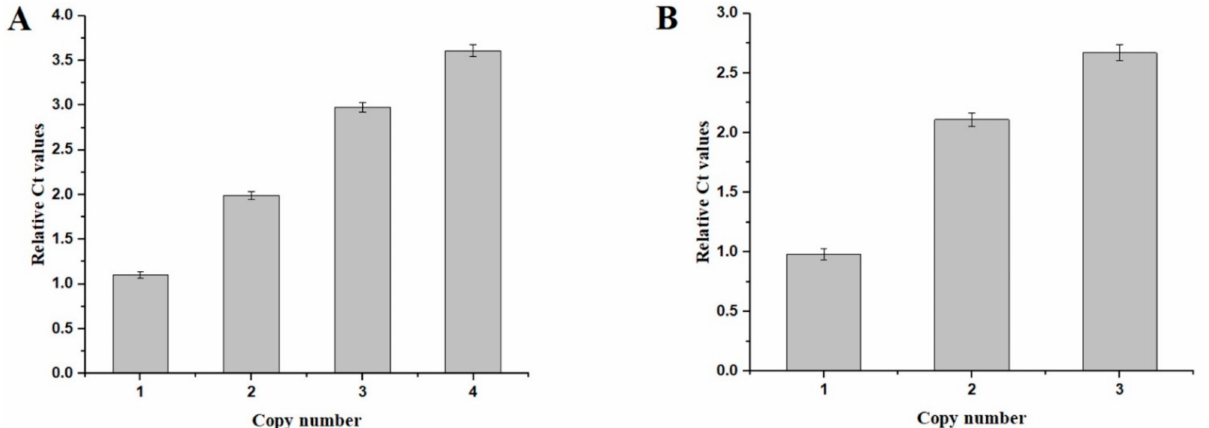
Figure 3. qPCR-based evaluations of the copy numbers of the recombinant strains. ( A ) qPCR of the CDA expression cassettes integrated into the host strains. ( B ) qPCR of the CDA-AG α 1 expression cassettes integrated in the host